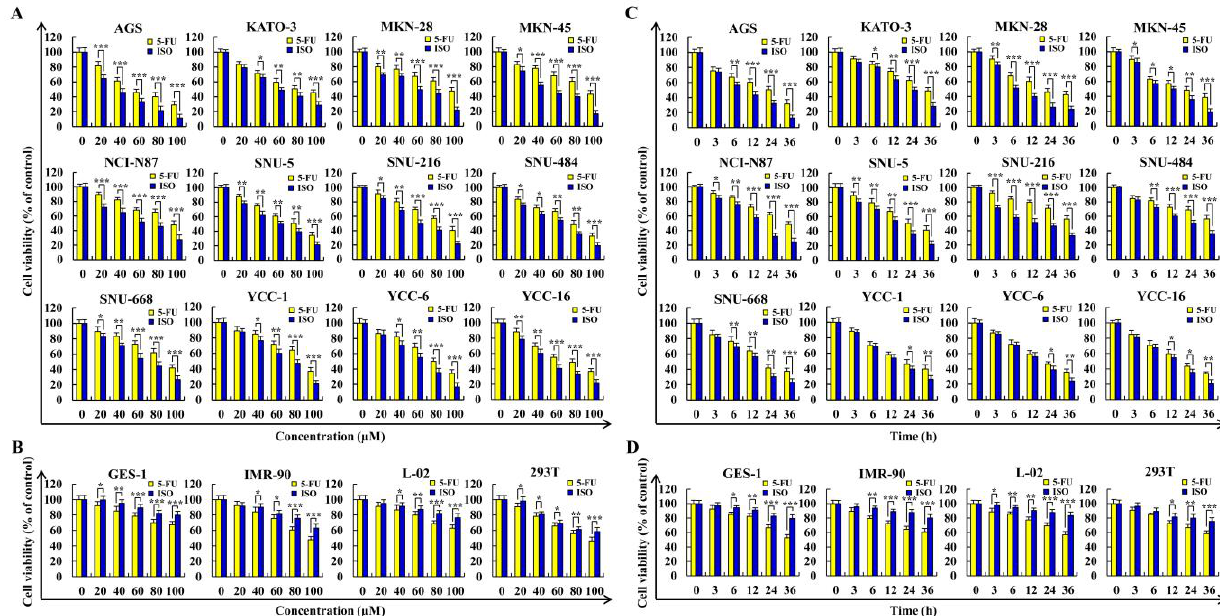
Figure 1. The cytotoxic effect of ISO. The CCK-8 assay was used to determine if cells had survived after being exposed to various doses or time of 5 – FU or ISO. ( A ) Survival rate of gastric cancer cells. ( B ) Survival rate of normal cells. ( C ) Survival rate of gastric cancer cells. ( D ) Survival rate of normal cells. * p < 0.05, ** p < 0.01 and *** p < 0.001 vs. 5 – FU.